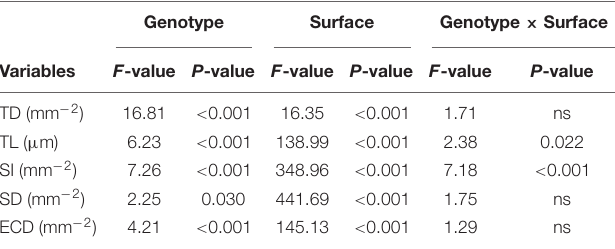
TABLE 3 | Summary of the effects of genotype, adaxial and abaxial leaflet surfaces, and their interaction on micromorphological leaflet traits in wild and cultivated lentil.